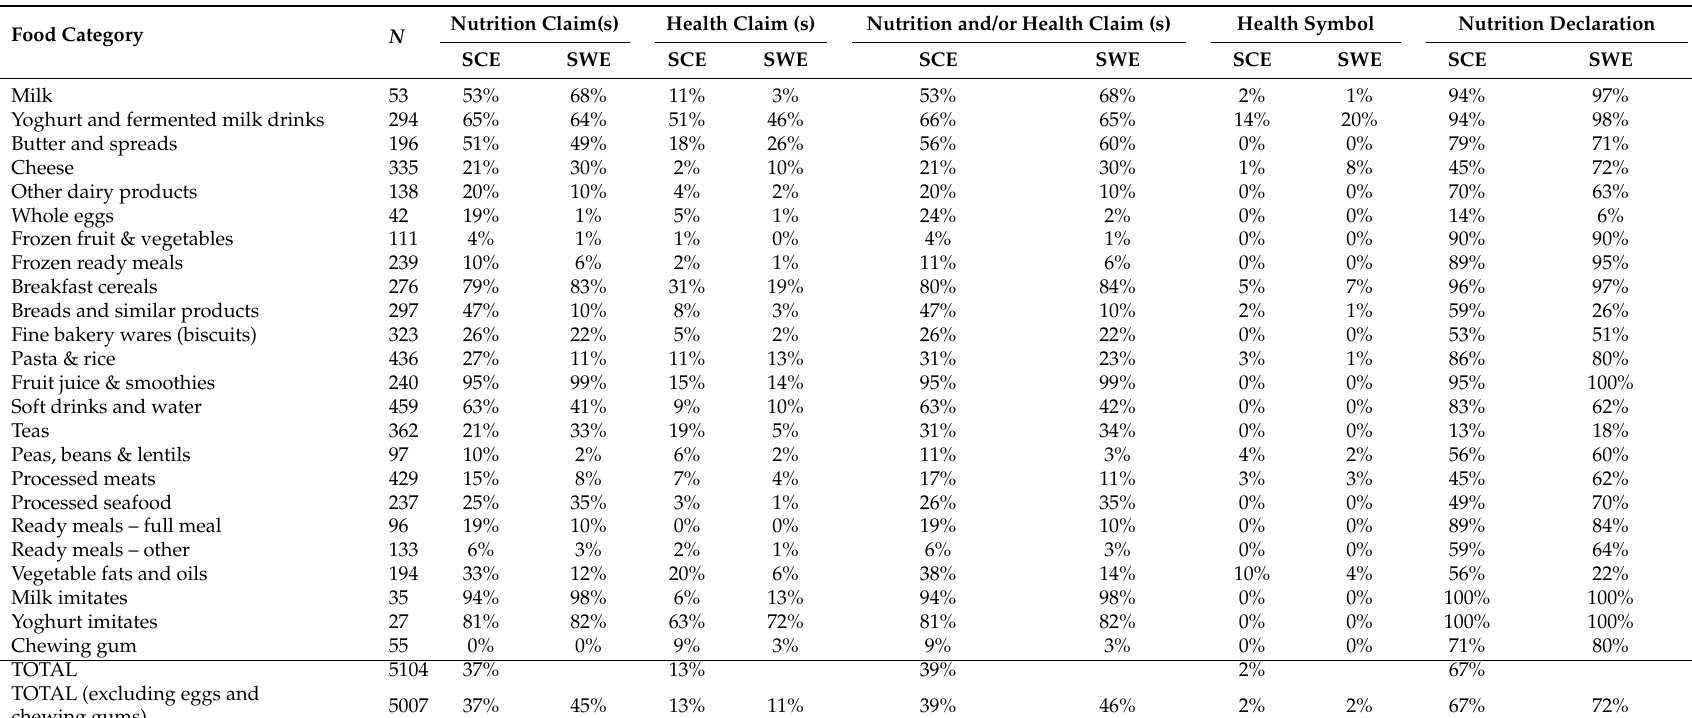
Table 2. Consumer’s exposure to nutrition and health claims and symbols on pre-packed